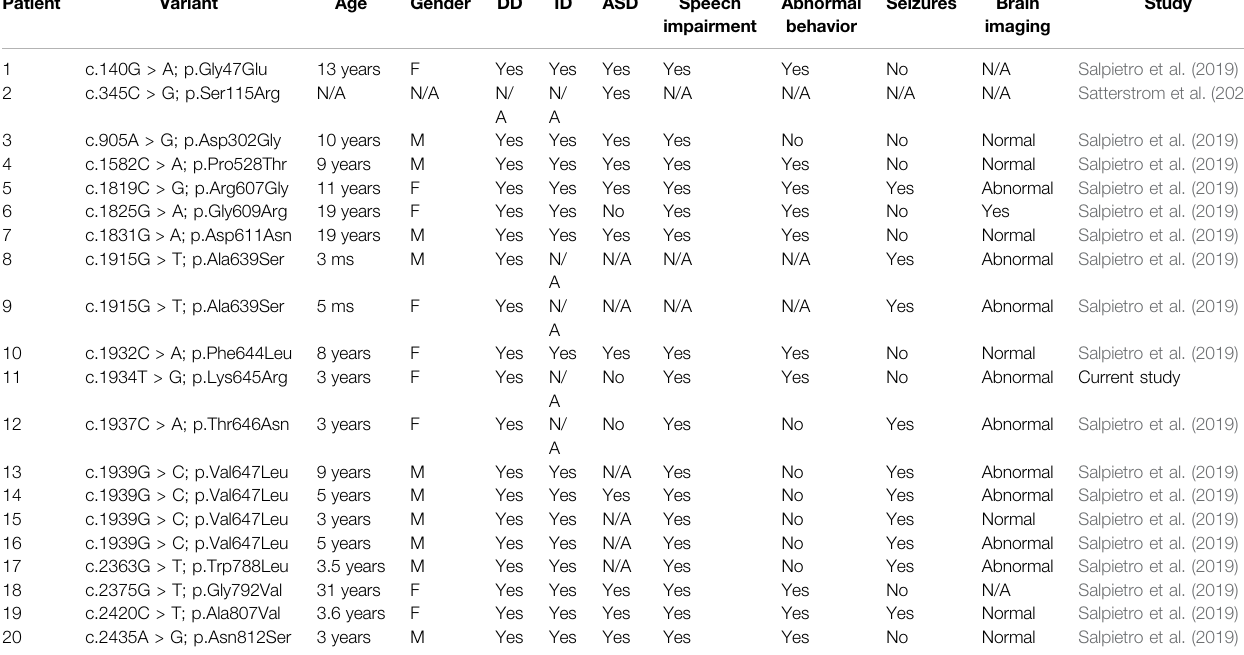
TABLE 1 | Clinical phenotypes of patients with missense variation of the GRIA2 gene reported to date.